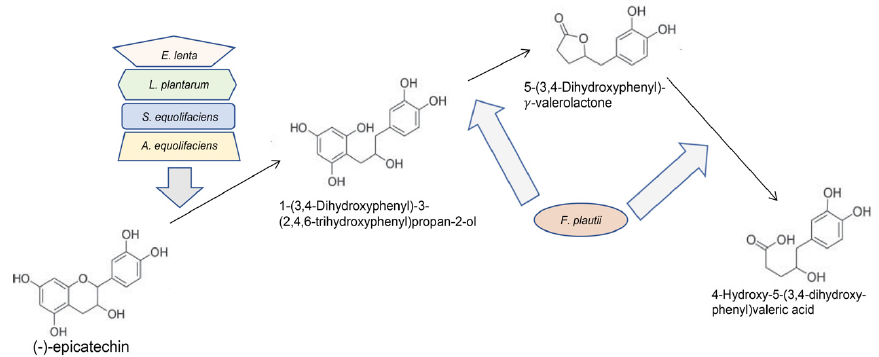
Figure 1. Initial products of metabolism of green tea (GT) (-)-epicatechin (EC). Four gut bacteria have enzymes to execute the first C ring cleavage step, while F plautii has been shown to be capable of further